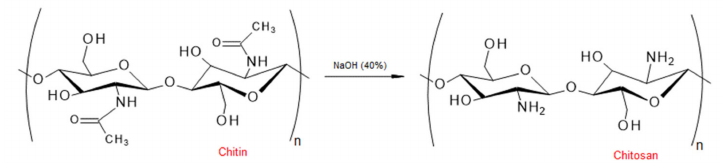
Figure 6. Schematic procedure of preparation of chitosan from chitin (summarized by